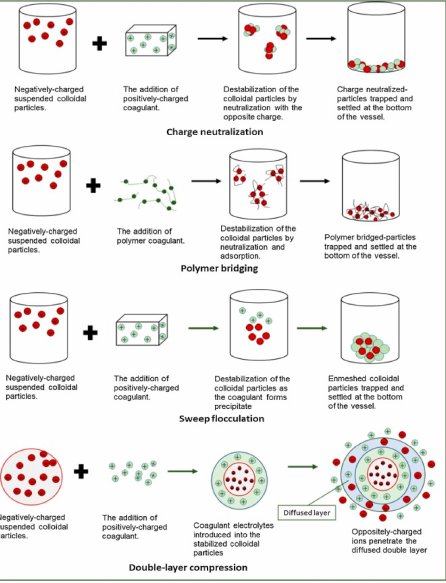
Figure 1. Coagulation mechanisms diagram showing charge naturalization, polymer bridging, sweep flocculation, and double-layer compression, copied with permission from Ref. [10], Copyright, 2021,